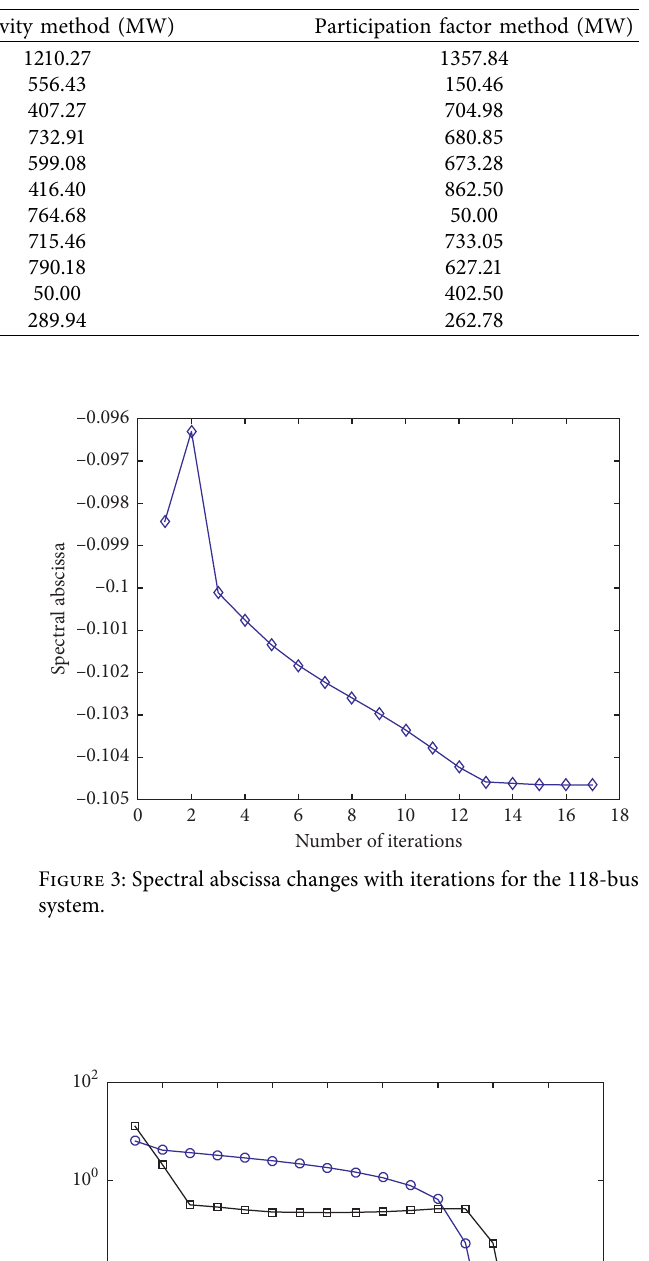
Table 2: Comparison of different methods for the 39-bus